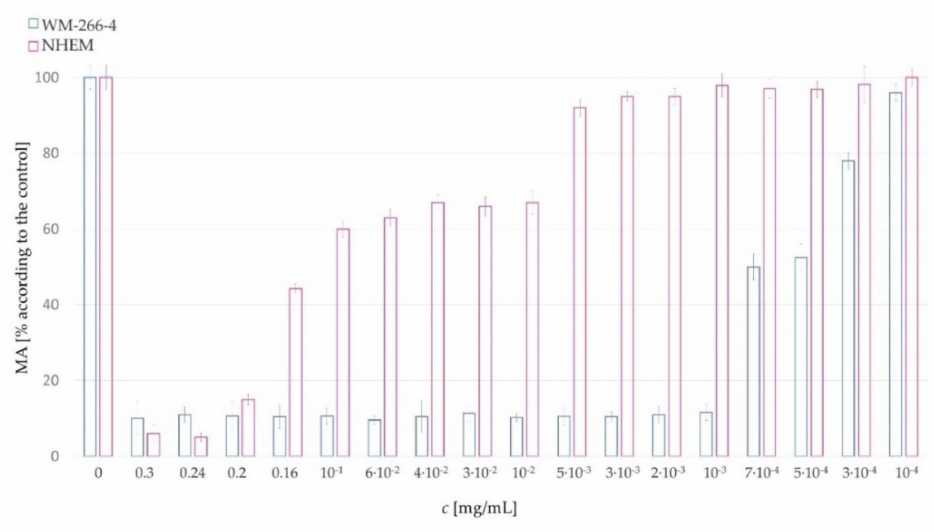
Figure 7. Metabolic activity of melanoma cells WM − 266 − 4 at different concentrations of